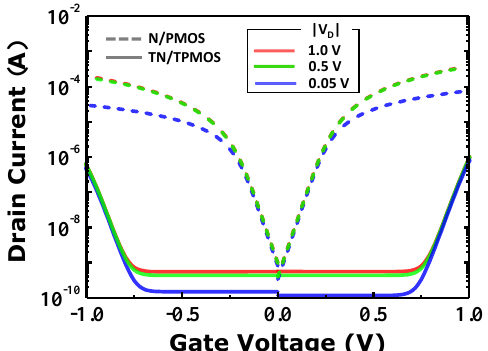
Figure 2. The transfer characteristics of conventional NMOS / PMOS and TNMOS / TPMOS. Due to the I OFF generated from the tunnel junction, the I OFF increases with the larger drain voltage. Compared